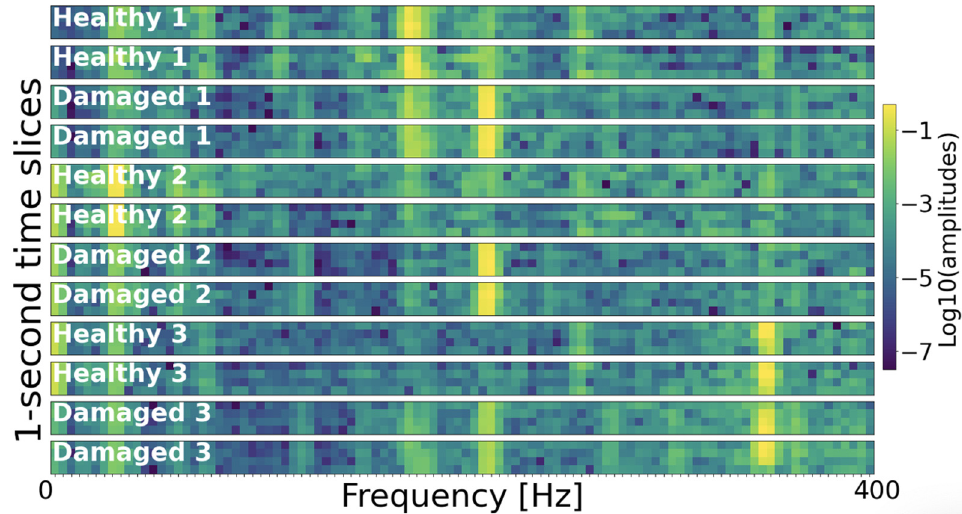
Figure 6. Subsets of the spectrograms derived from the vibration measurements of the three accelerometers at the healthy and the damaged gearbox components. Two healthy and two damaged instances are shown for each of the three components. For instance, “Healthy 1” labels two different 1 s spectrogram segments of component 1 in healthy state. Each spectrogram segment runs over 1 s and displays logarithmic STFT amplitudes for frequencies up to 400 Hz.